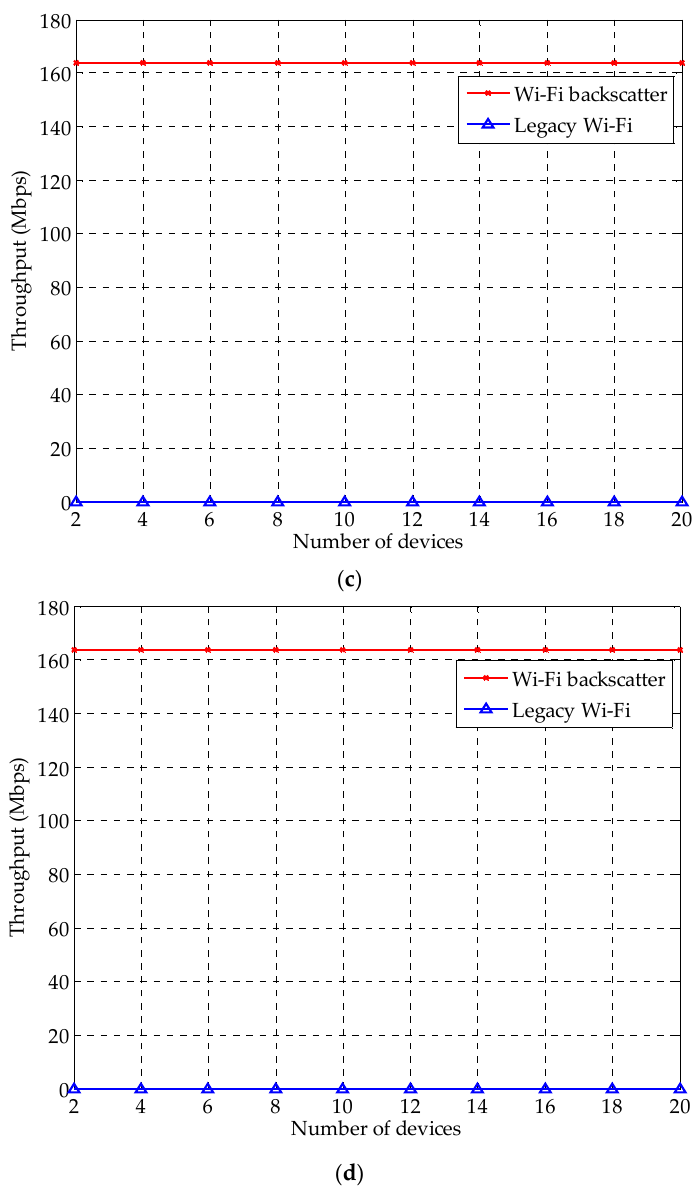
Figure 7. Variation of throughput for composite cases: ( a ) CSMA/CA starting with SIFS + freezing of backoff period; ( b ) freezing of backoff period + reduced CW min = 1; ( c ) CSMA/CA starting with SIFS + reduced CW min = 1; and ( d ) all of the MAC configurations.